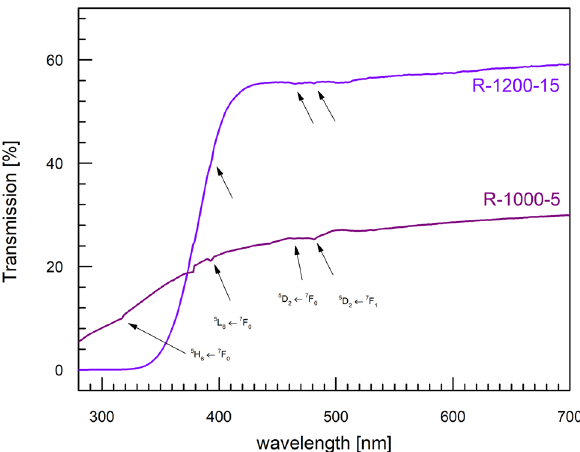
Figure 6. Transmission spectra of two samples: R-1200-15 (purple line) and R-1000-5 (violet line). 3 + Characteristic electron transitions of Eu ions were identified, marked with arrows and annotated.